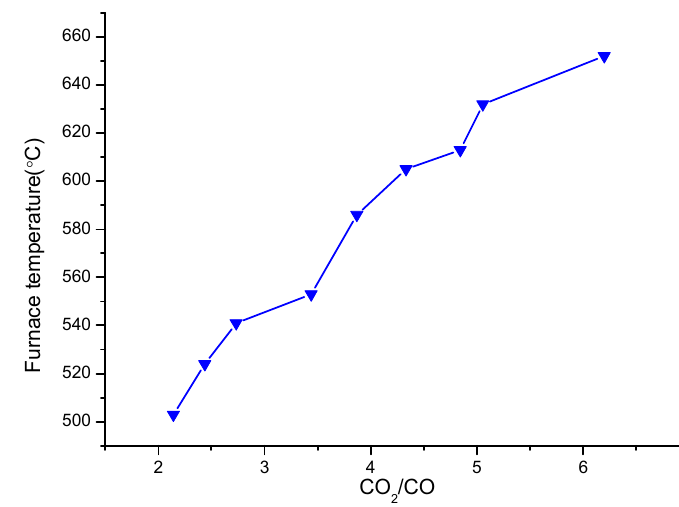
Figure 3. Relationship between furnace temperature and CO 2 /CO ratio.